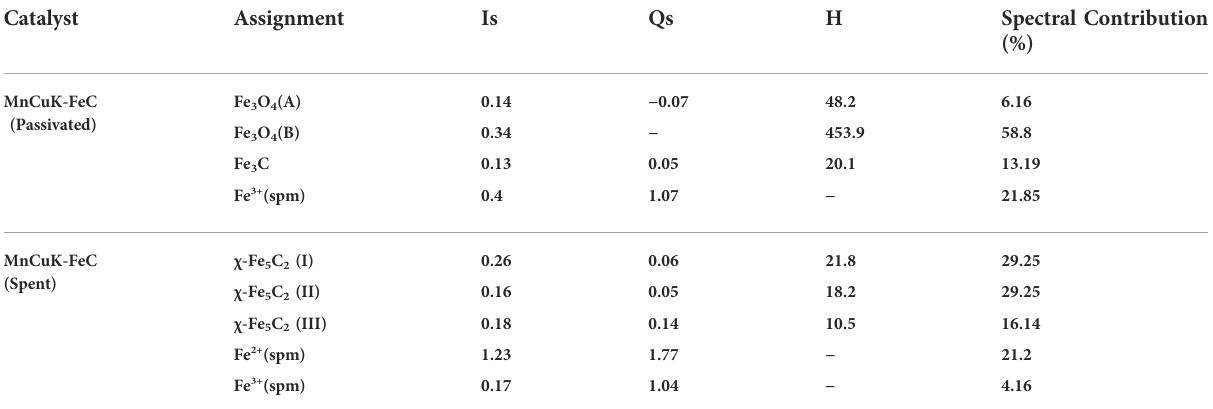
IS, Isomer shift; QS, Q. Splitting; H, Magnetic fi eld.